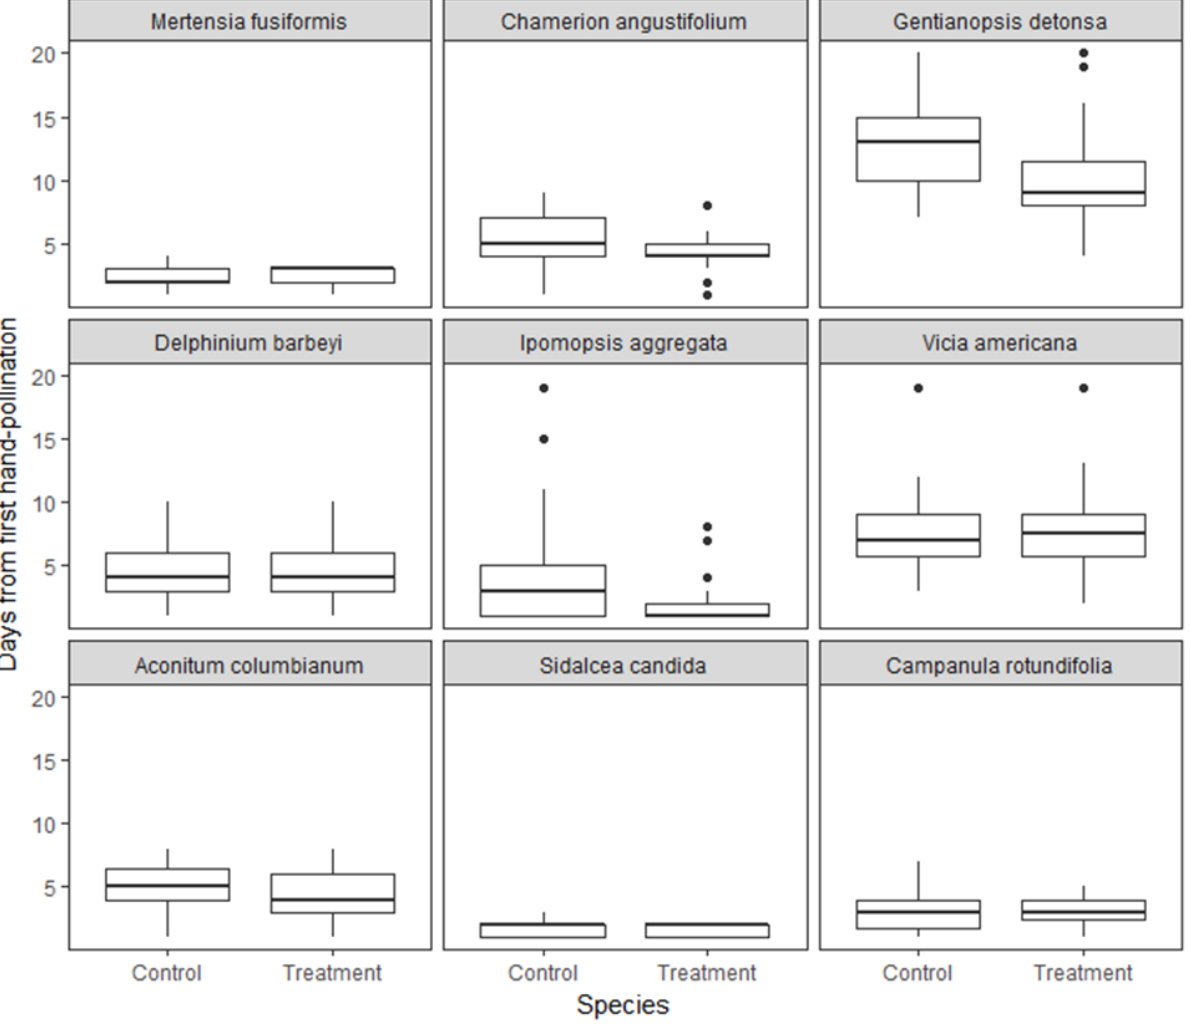
F IGURE 2. Floral longevity of nine plant species in or near the Rocky Mountain Biological Laboratory, Gothic, Colorado, USA. Experimental flowers were hand-pollinated once receptive, while control flowers were not pollinated. Sample sizes, in pairs, for the species, in order from left to right, top to bottom: 13, 25, 19, 29, 28, 28, 27, 26,